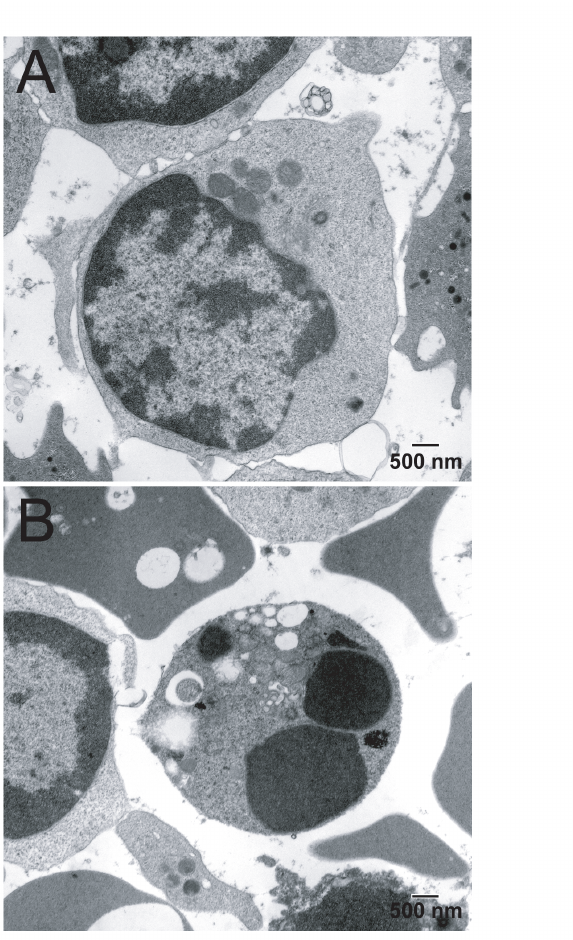
Figure 4:Electronmicrographof (A)untreatedratperipheralblood lymphocyte and (B) rat peripheral blood lymphocyte exposed to 30 µ M CI-994 for 24hours. Mitogen (concanavalin A, 0.63 µ g/ml) was added to all lymphocyte cultures at time zero. Treated lym- phocyte shows morphological changes of apoptosis including chro- matin condensation and fragmentation, membrane blebbing, and cell shrinkage.